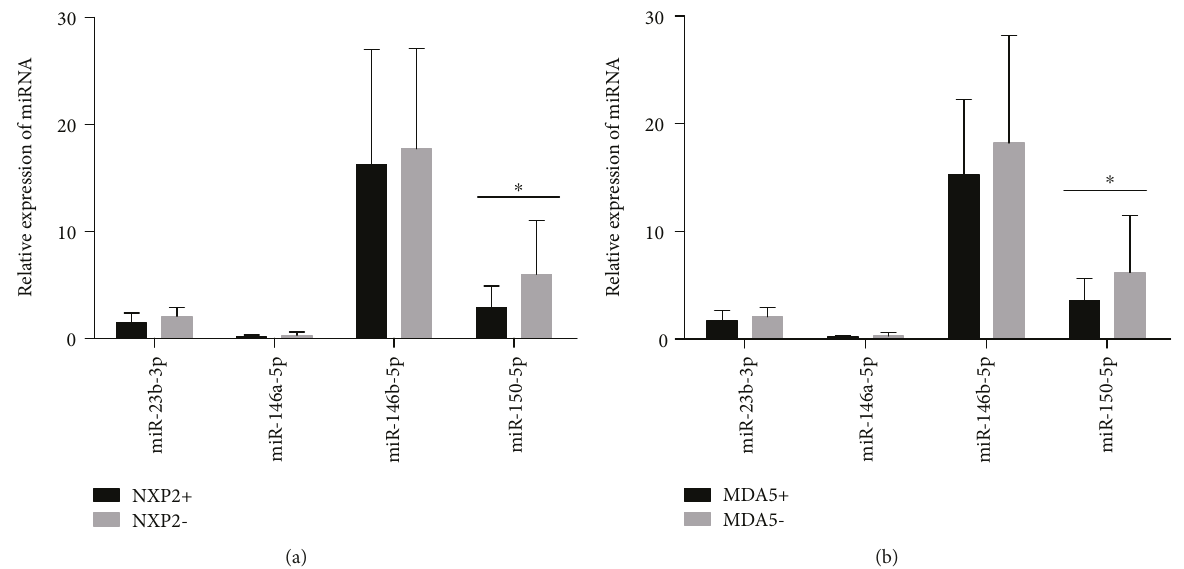
Figure 3: Associations between serum miRNA levels and MSAs. (a) Serum miR-150-5p levels were signi fi cantly downregulated in DM patients with anti-NXP2 antibodies ( 3 58 ± 2 02 , 11 cases) compared with those without anti-NXP2 antibodies ( 6 19 ± 5 27 , 38 cases; P = 0 047 ). (b) Serum miR-150-5p levels were also lower in DM patients with anti-MDA5 antibodies ( 3 58 ± 2 02 , 11 cases) than in those without anti-MDA5 antibodies ( 6 19 ± 5 27 , 38 cases; P = 0 017 ). Then, 2-group comparisons were performed using the Mann- Whitney U test. All P values were two-sided, and P value < 0.05 was statistically considered signi fi cant. MDA5: melanoma di ff erentiation- associated gene 5; NXP2: nuclear matrix